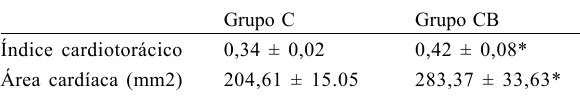
Tabela 1. Resultados das análises radiológicas, com imagens obtidas pelo estudo radiológico em projeção póstero- anterior.